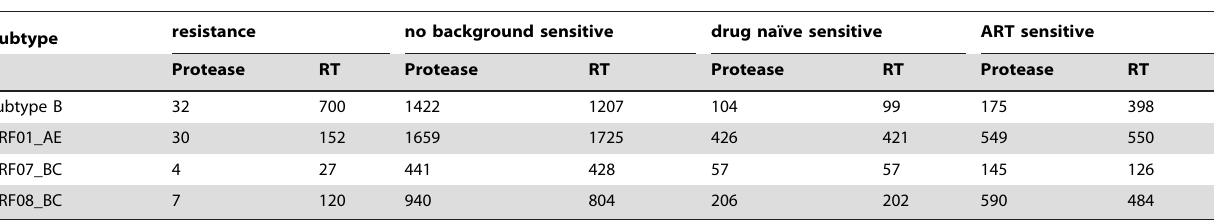
Table 1. Sequences